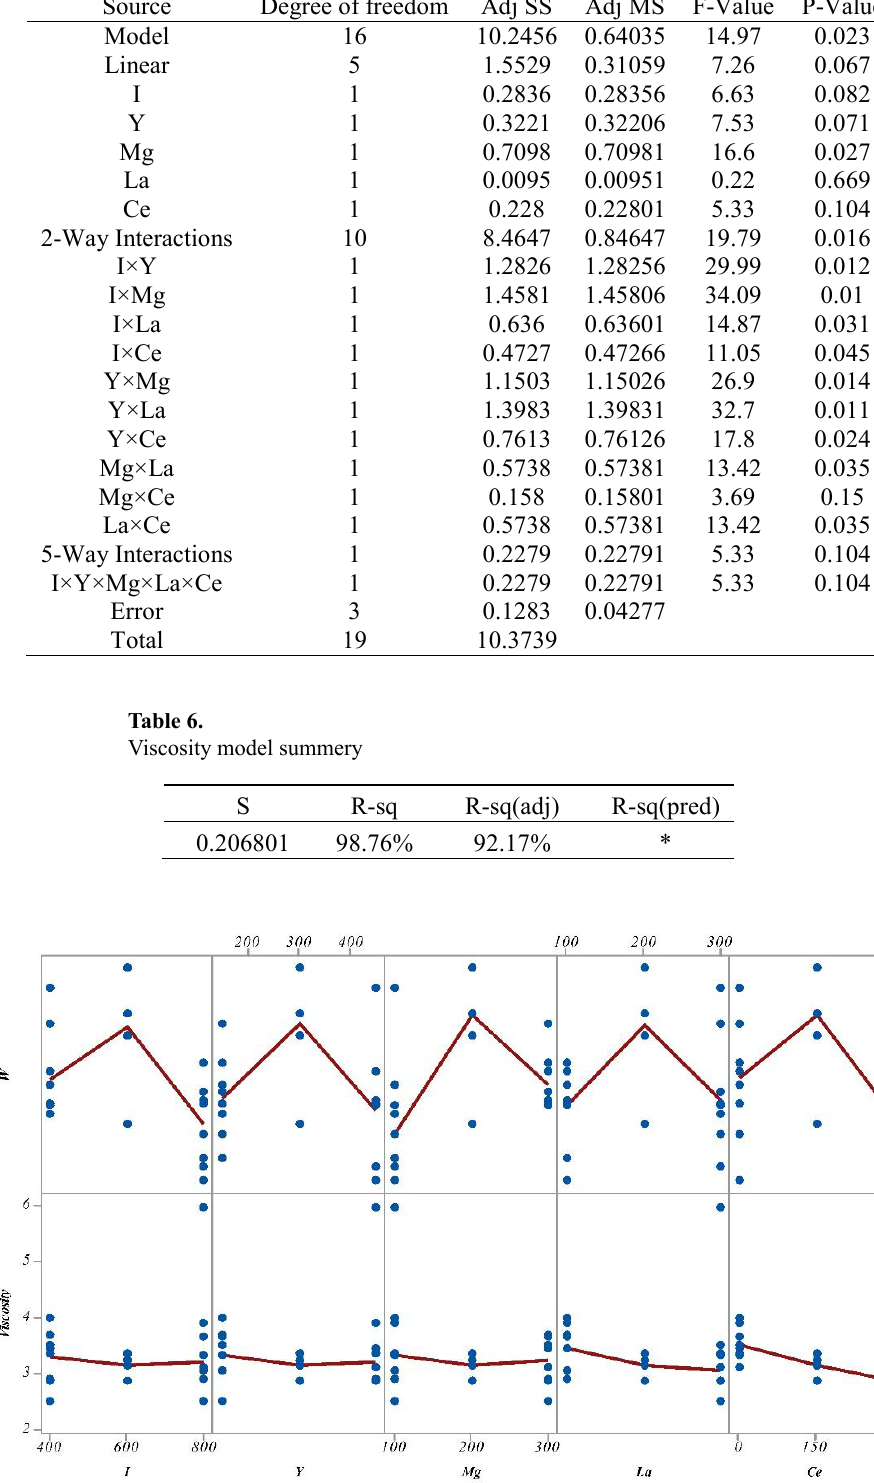
Fig. 7. Matrix plots of viscosity (mPa.s) and deposition weight (g) vs. additive concentrations